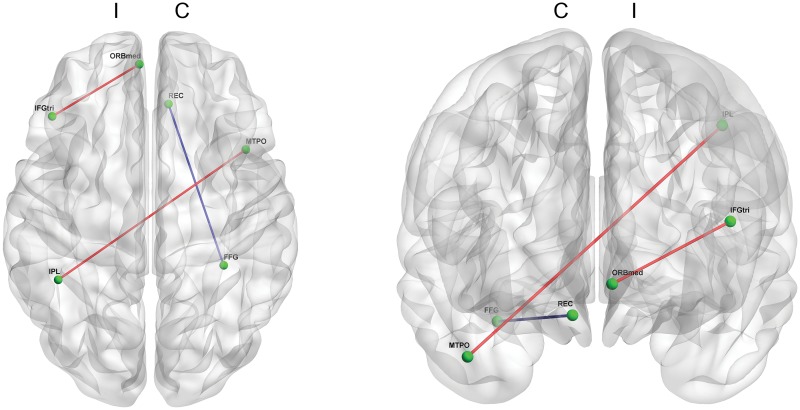
Functional connectivity correlated with the MDS-UPDRS part II score.Limited functional connectivity is shown to correlate with the MDS-UPDRS part II score. This score positively correlates with the functional connectivity between the pars triangularis and the orbital part of the medial frontal gyrus within the ipsilateral hemisphere, and with the connectivity between ipsilateral inferior parietal lobule and contralateral middle temporal pole. The MDS-UPDRS part II has a negative correlation with the connectivity between rectal gyrus and the fusiform gyrus in the contralateral hemisphere. (p<0.001) (Blue line: a functional connectivity negatively correlated with the MDS-UPDRS part II score & red line: a functional connectivity positively correlated with the MDS-UPDRS part II score; C: contralateral hemisphere & I: ipsilateral hemisphere; MDS-UPDRS: Movement Disorder Society-sponsored revision of the Unified Parkinson’s Disease Rating Scale)